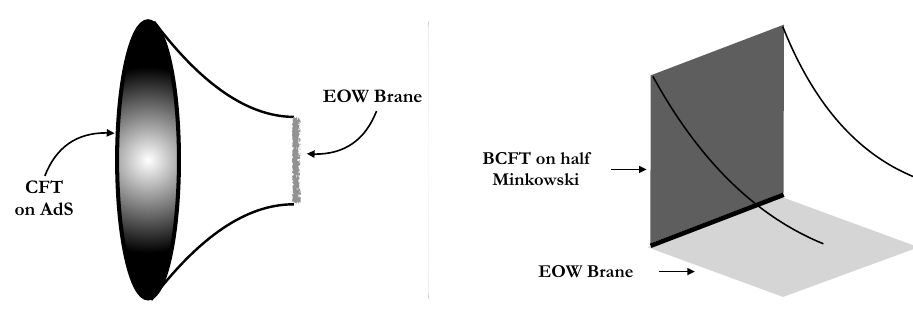
Figure 5 . Single-AdS-boundary solution vs. flat